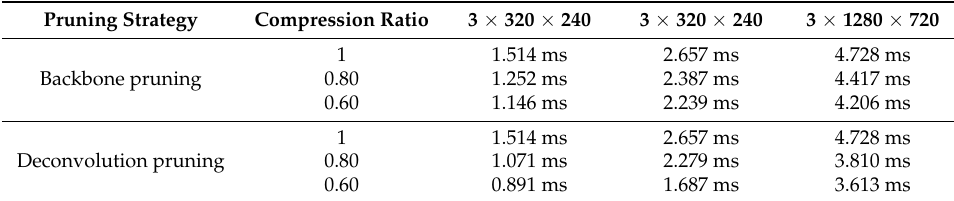
Table 5. Inference latency at different input